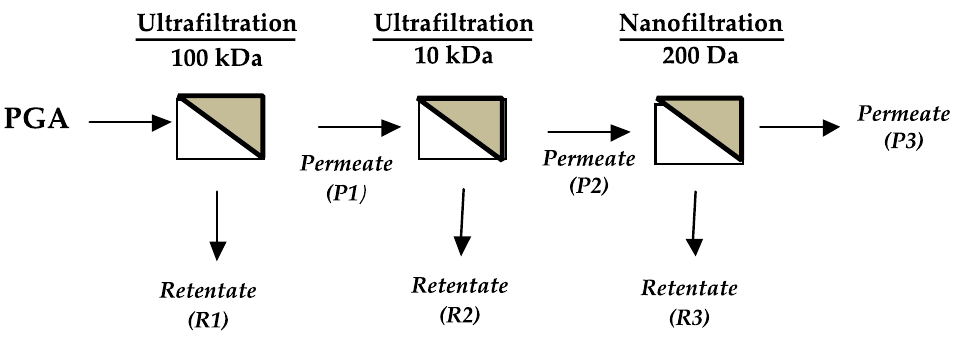
Figure 2. PGA downstream process flowchart.